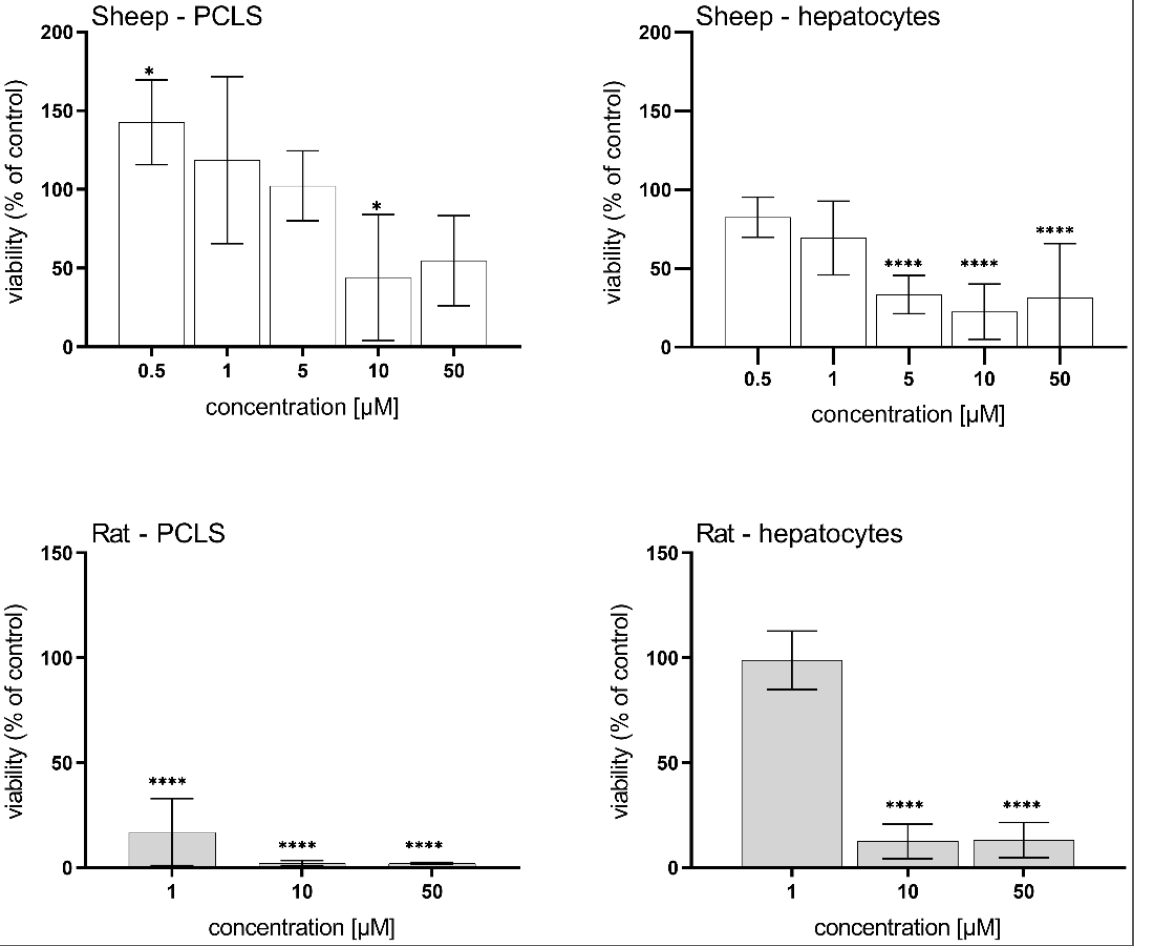
Figure 5. Effect of compound HBK4 on the viability of precision-cut liver slices (PCLS) and isolated hepatocytes of ovine and rat. The data are expressed in percentage of viability of the controls (=100%) and as means ± SD ( n = 3). For statistical analysis, one-way ANOVA with Dunnett’s multiple comparison test was used. *, p < 0.5; ****, p <